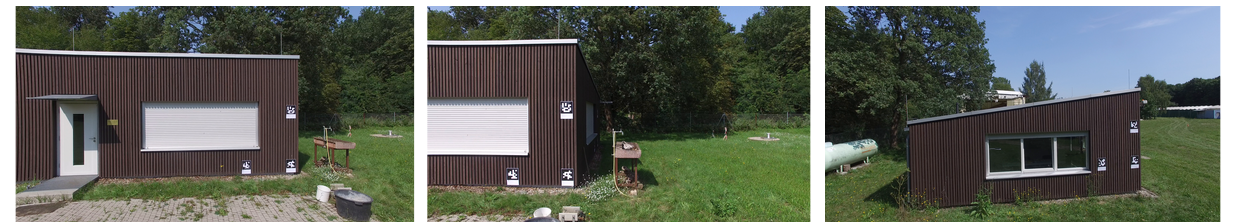
Figure 7. Images that cannot be registered by our